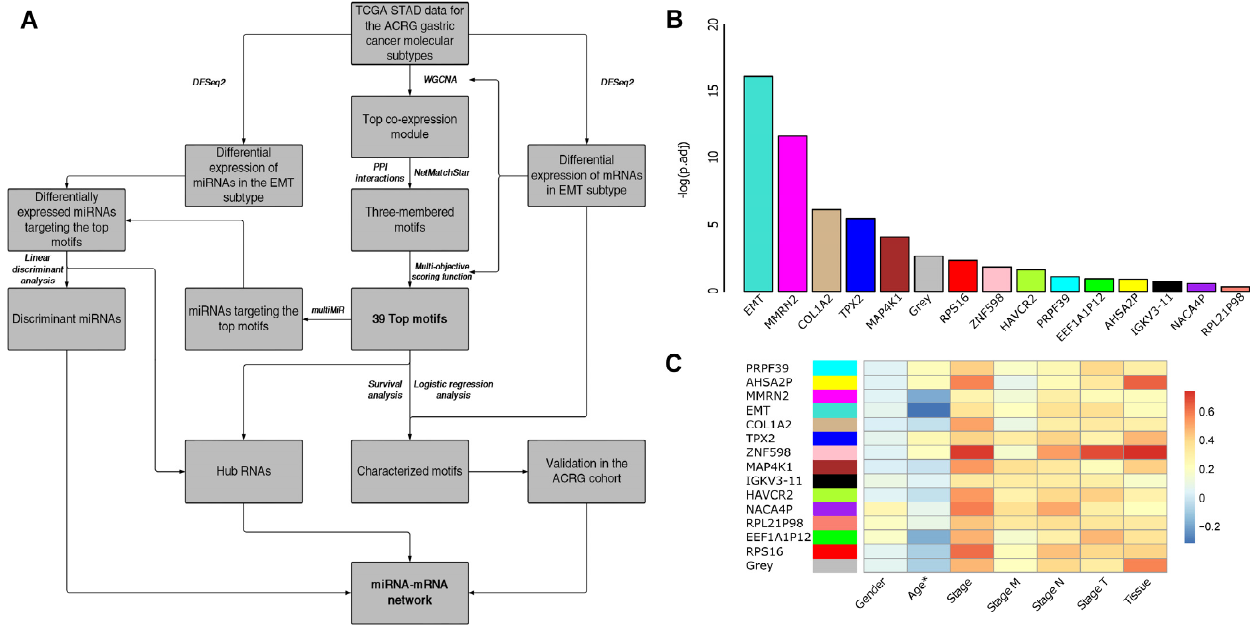
Figure 1. Workflow and co-expression modules. ( A ) Schematic presentation of the overall workflow of this study; ( B ) Bar plot of module significance (defined here as the minus logarithm of the adjusted p -values of the differential expression of all the members of a module in the epithelia-mesenchymal transition (EMT) subtype in comparison to the pooled samples of the other subtypes); ( C ) Association of the co-expression modules with clinical parameters. There is a significant negative correlation between the eigengene of the EMT module and the age at diagnosis (R = − 0.31; p -value = 0.03). It should be noted that since all of the co-expression modules were identified on the same set of samples, the observation that the eigengene of the EMT module is negatively correlated with the age at diagnosis is not biased by possible age imbalances in the data. Tumor staging system: T—size and spread of the primary tumor; N—level of spread to lymph nodes;